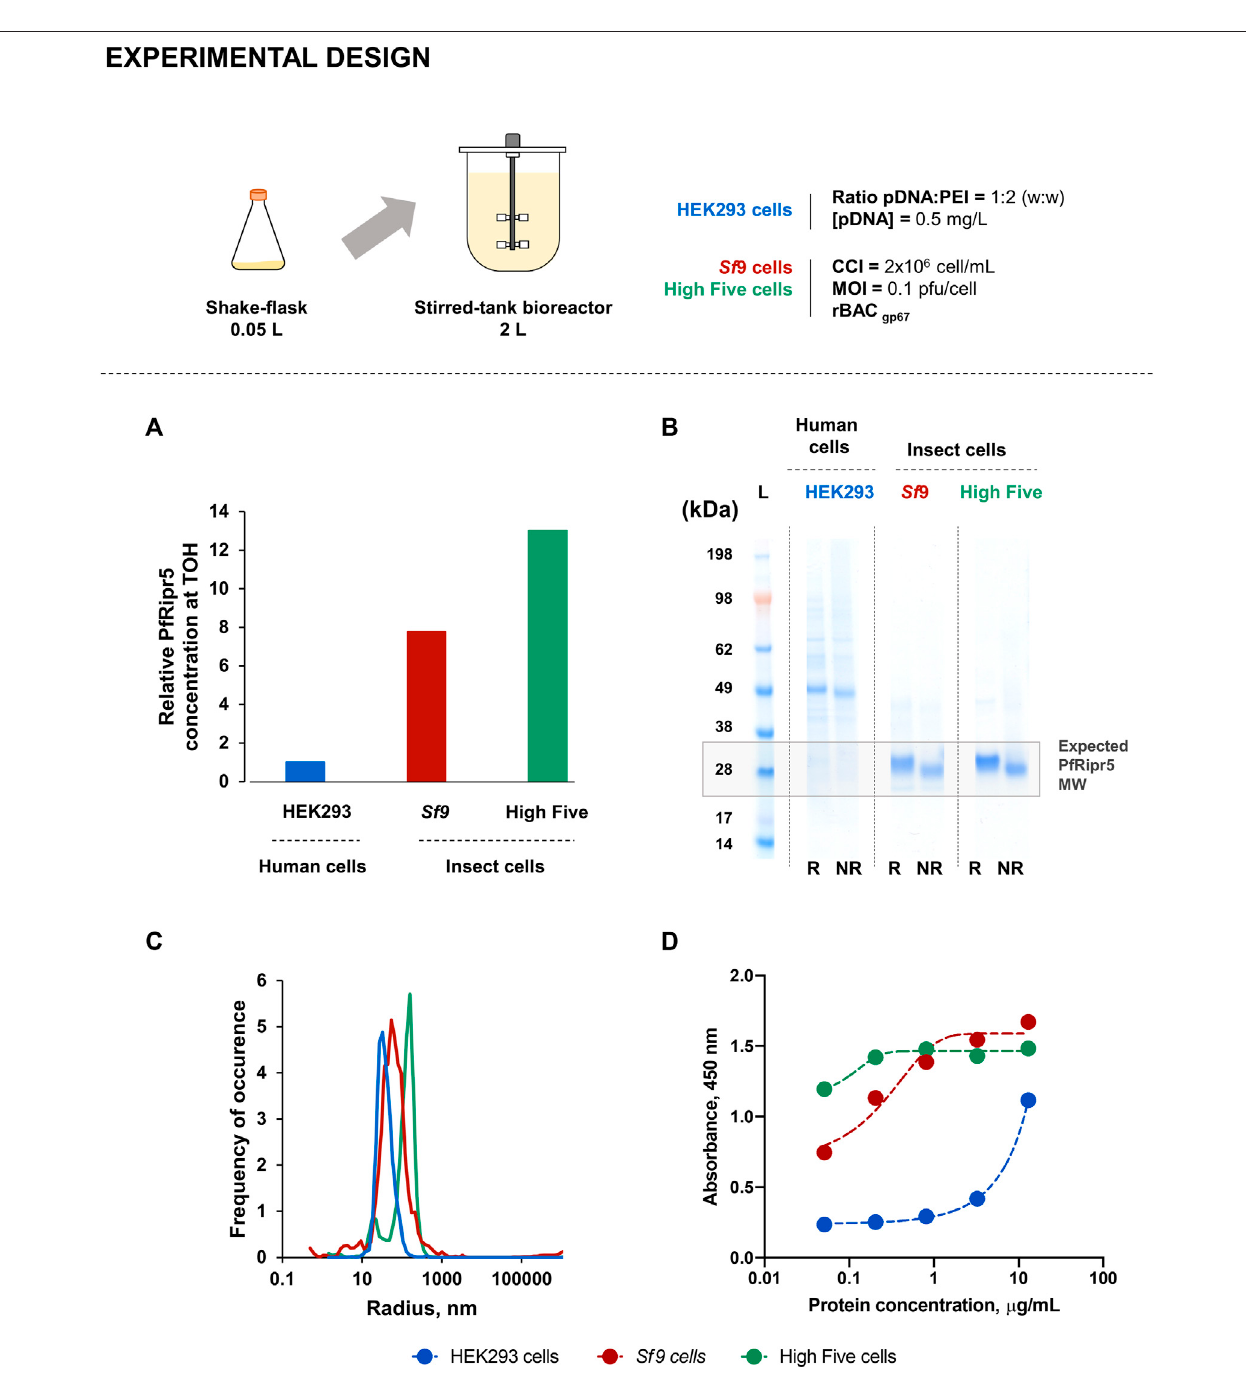
FIGURE 3 | Production of PfRipr5 at 2 L stirred-tank bioreactor (STB) scale. (A) Relative PfRipr5 concentration at the TOH of each cell line. (B) SDS-PAGE of puri fi ed PfRipr5. (C) Size distribution pro fi le of puri fi ed PfRipr5 assessed by dynamic light scattering. (D) ELISA of puri fi ed PfRipr5 using an anti- P. falciparum PfRipr mouse monoclonal antibody(mAb)29B11.For fi gure (A) :relativePfRipr5expressionwasassessedbyadensitometryanalysisofwesternblot( SupplementaryFigure S2B ) as described in the M&M section. For fi gure (B) : L denotes pre-stained protein standard SeeBlue ® Plus2, R denotes reduced sample, NR denotes non- reduced sample. Data are relative to one biological replicate ( n =